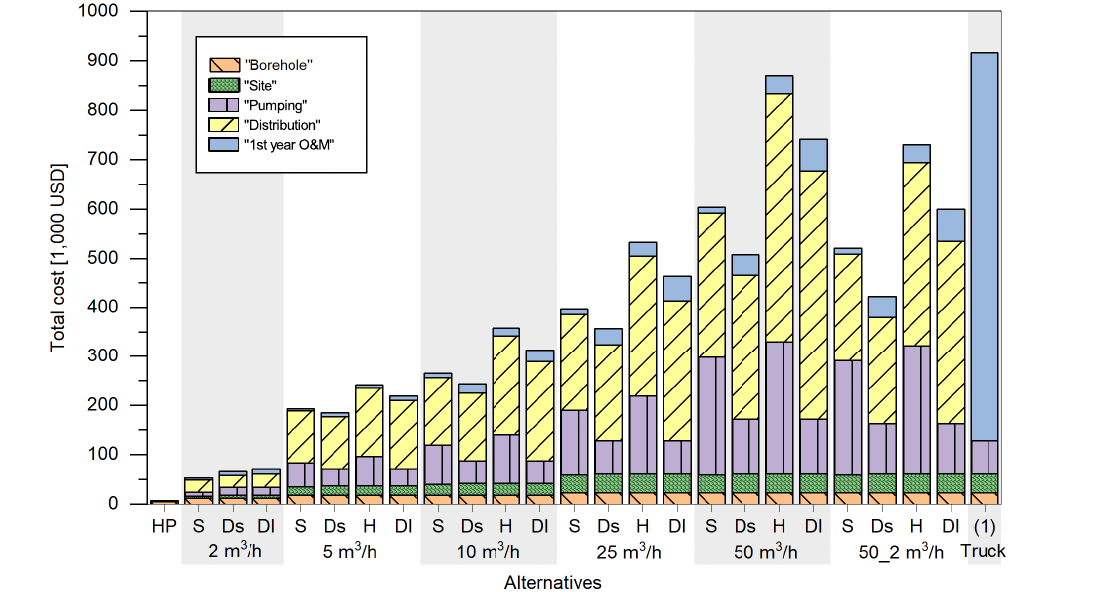
Figure 3. Total costs (capital expenditure (CAPEX) + operational expenditure (OPEX)) encountered within the first year of operation. HP: hand pump; S: solar; Ds: short-running diesel; H: hybrid; Dl: long-running diesel. Details in Supplementary Material A.14.